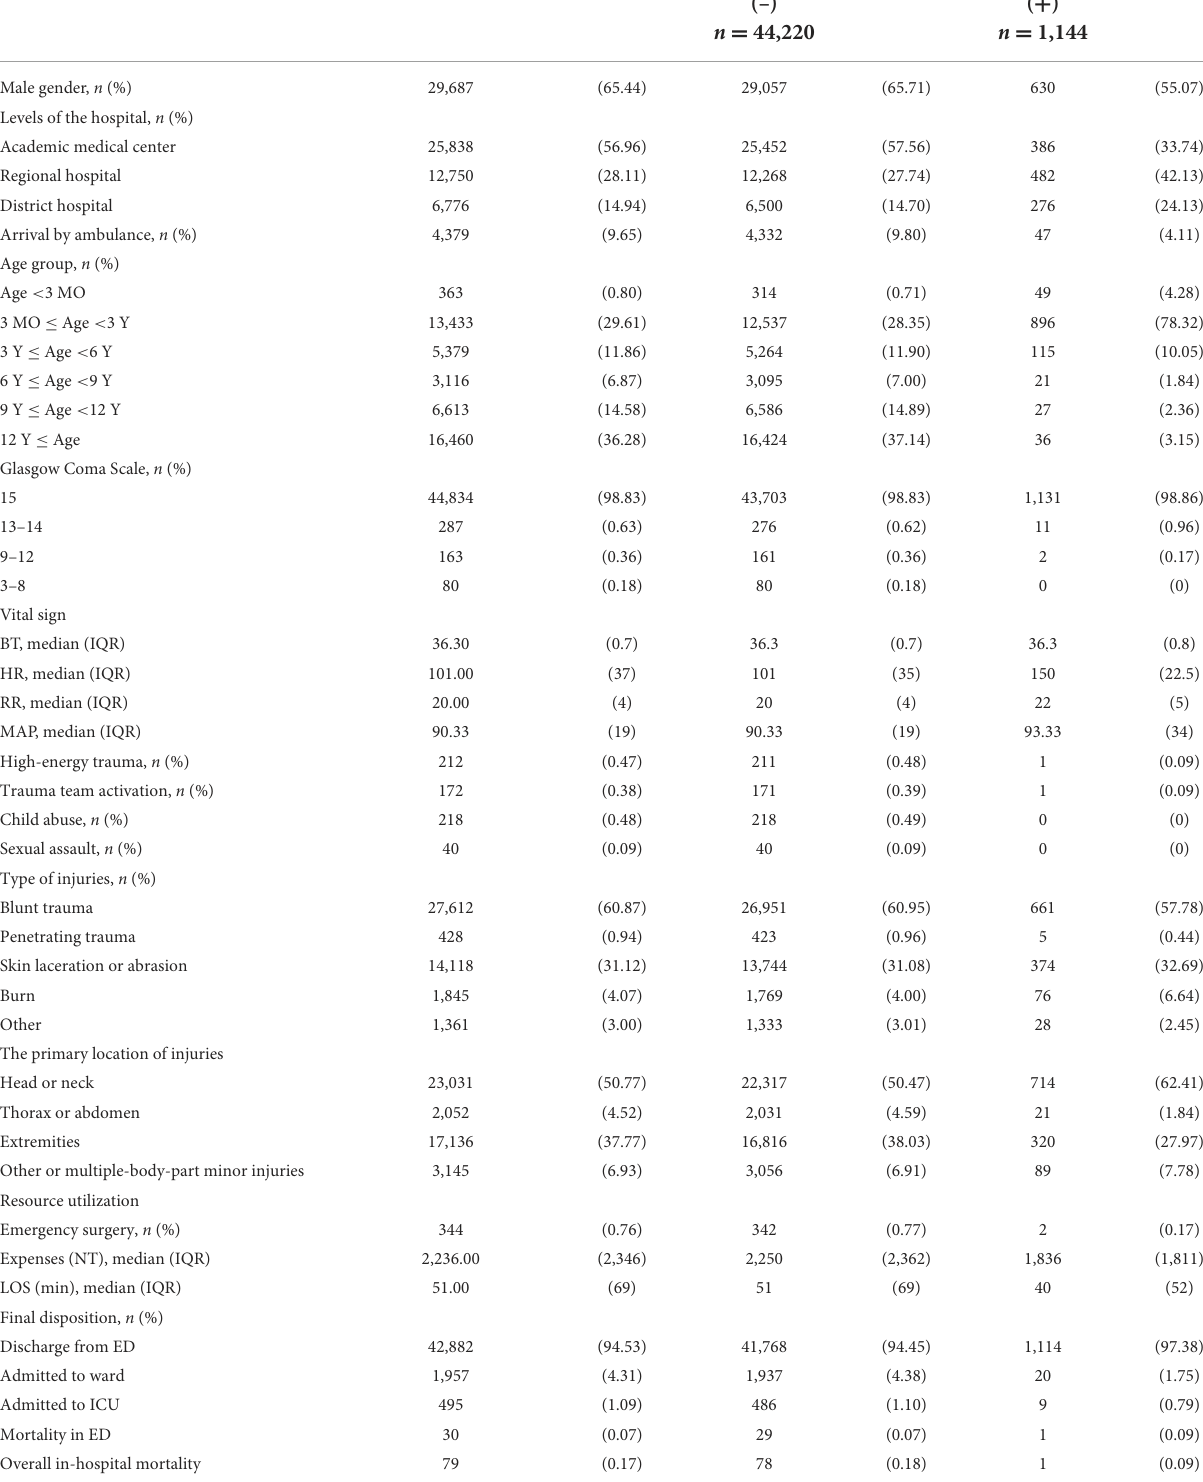
TABLE 1 Demographic in pediatric traumatic patients who visited the EDs from 2015 to 2019.